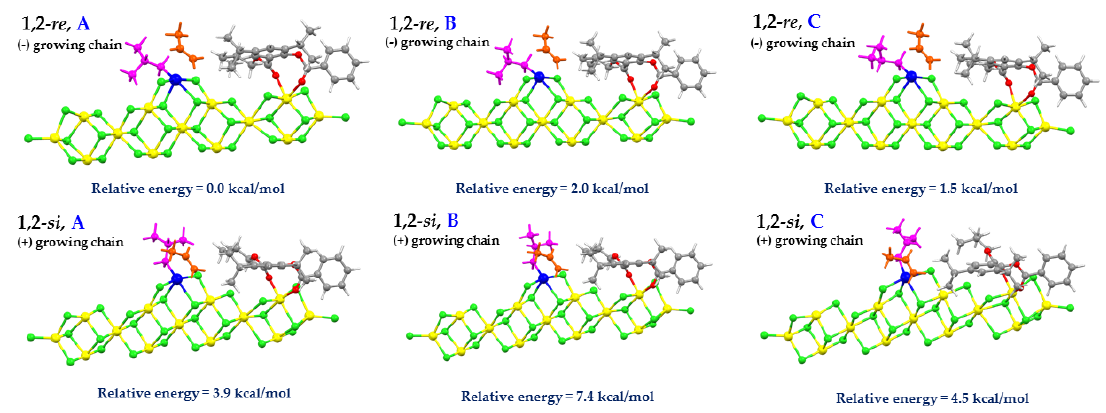
Figure 3. Six possible conformations of the i Bu growing chain for the π -complex of 1,2- re and 1,2- si insertions at the Ti mononuclear on the MgCl 2 (110) surface in the presence of salicylate donor (SID- 4). The insertion of propylene on the front side, 1,2- re , A and 1,2- si , A. The insertion of propylene on the backside, 1,2- re , B and 1,2- si , B. The insertion on propylene on the right side, 1,2- re, C and 1,2- si ,